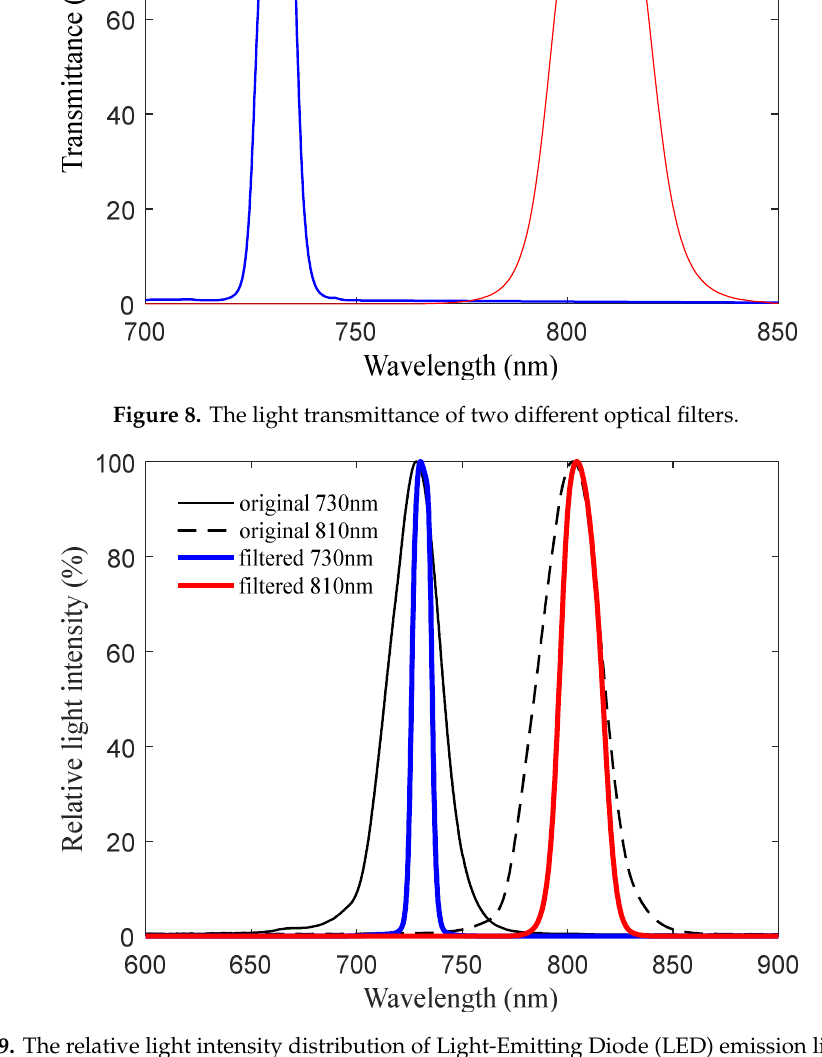
Figure 9. The relative light intensity distribution of Light-Emitting Diode (LED) emission light before and after being filtered by the optical filter.